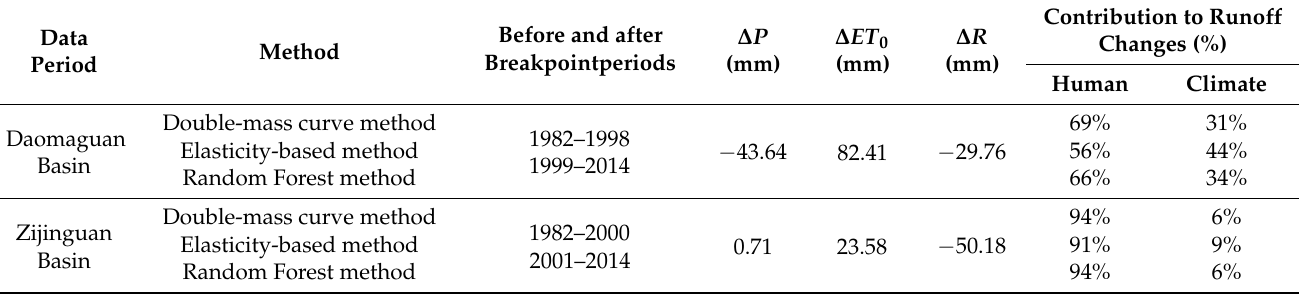
Table 2. Statistical results of double-mass curve, elasticity-based, and random forest methods includ- ing contribution rates, differences in annual averaged P , ET 0 , and R